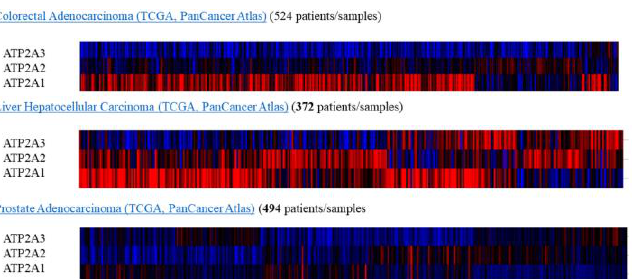
Figure 4. Expressions heatmap of SERCA isoforms in colorectal adenocarcinoma, liver hepatocellular carcinoma, and prostate adenocarcinoma. All data (TCGA PanCancer Atlas) collected from https://www.cbioportal.org/.